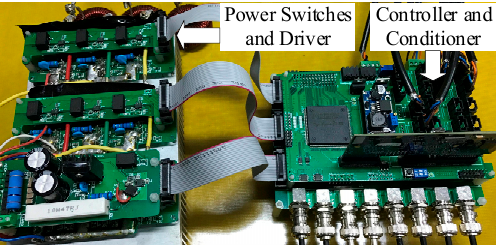
Figure 5. Picture of the experimental prototype. Table 3. Normal experimental parameters.